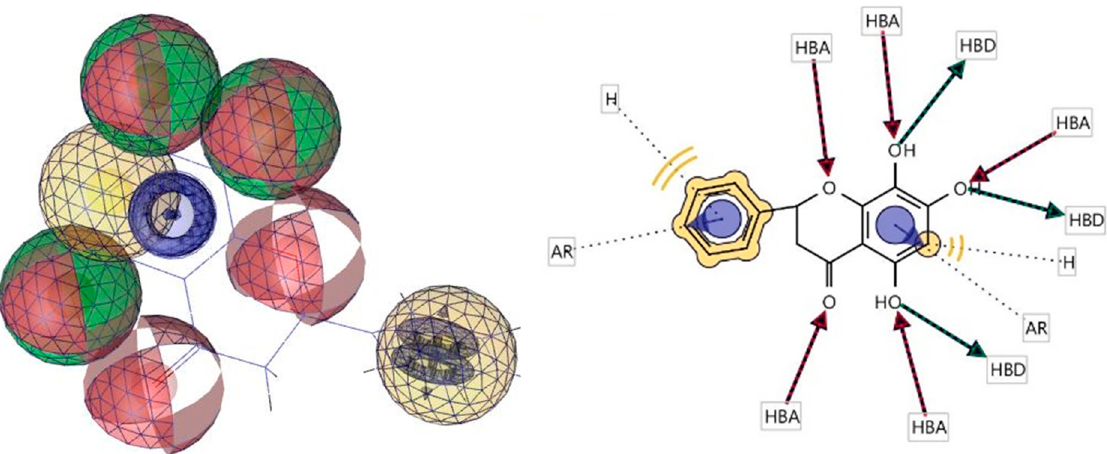
Figure 9. Three-dimensional and two-dimensional representations of pharmacophoric features of